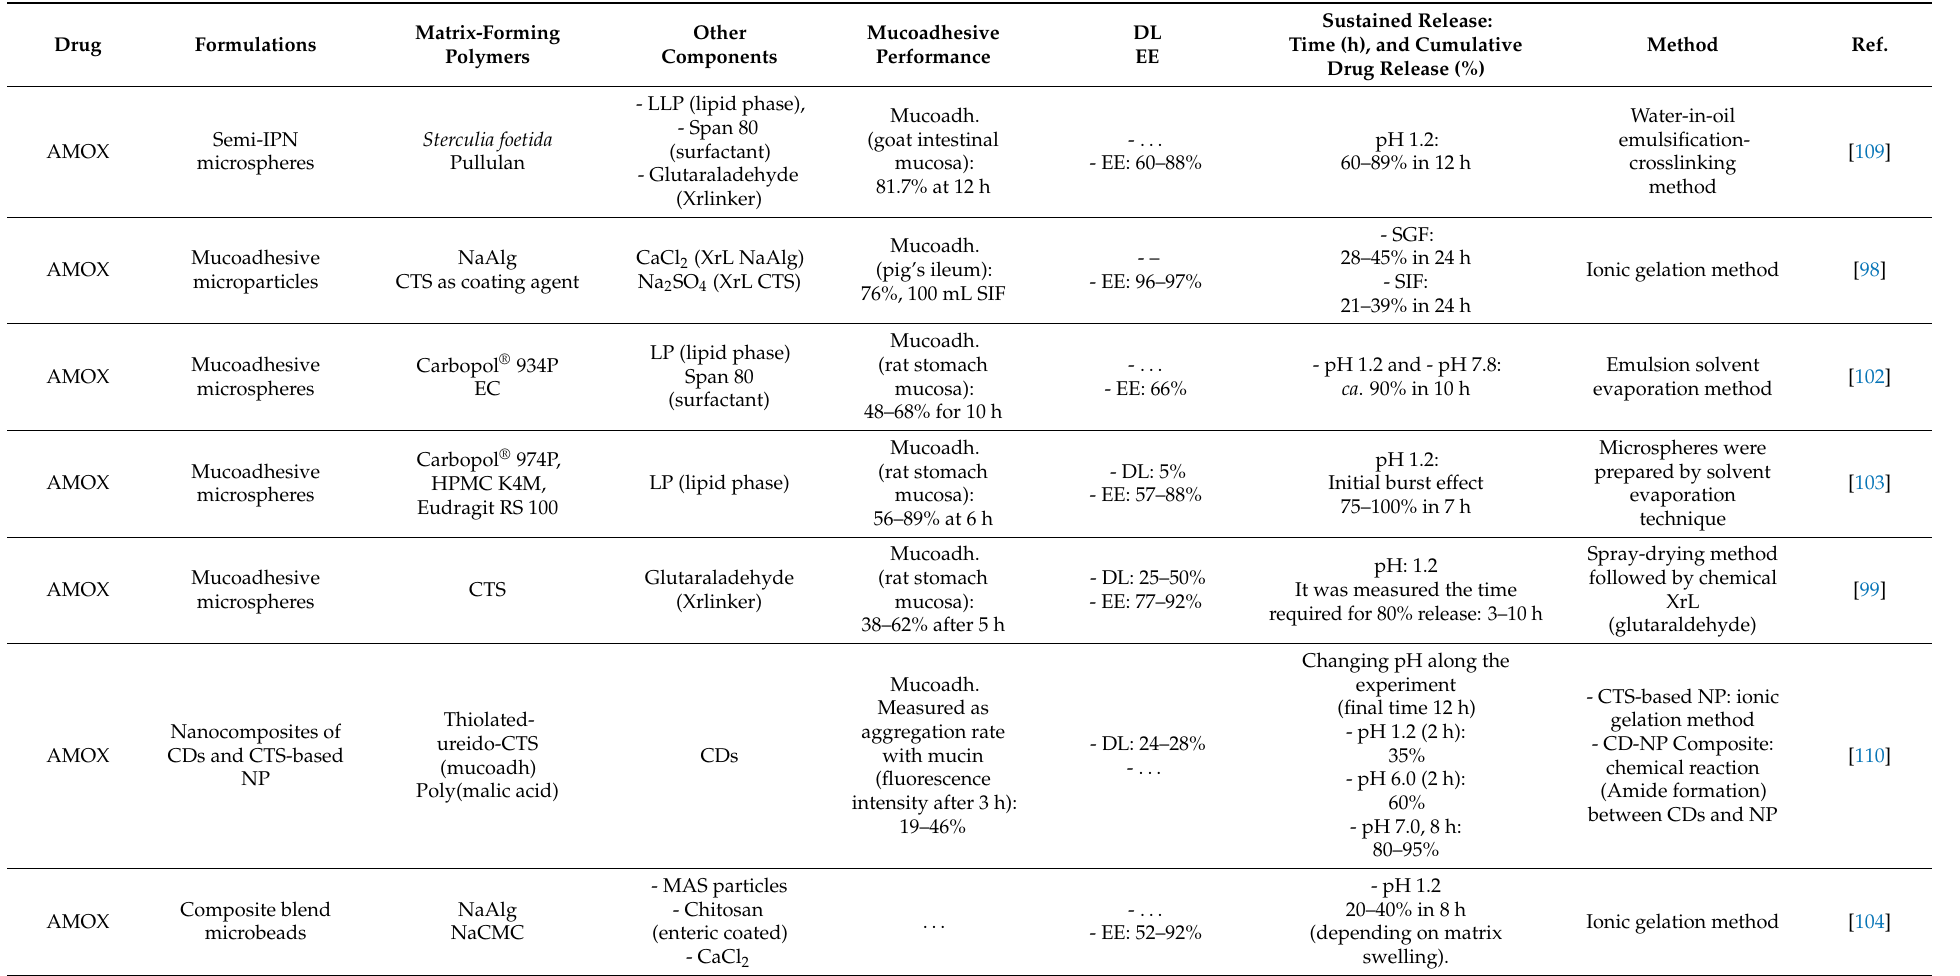
Table 4. Selected AMOX-loaded bioadhesive formulations used in the treatment of infections by H. pylori